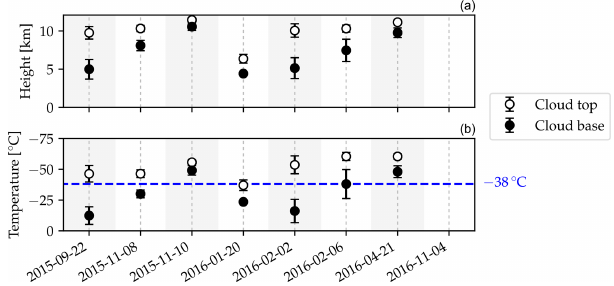
Figure 7. (a) Cloud top (circles) and base (dots) height were de- rived from cloud radar observations. (b) The corresponding tem- perature was estimated from radiosonde profiles launched at Ober- schleißheim. The dashed blue line indicates the threshold for ho- mogeneous nucleation at a temperature of − 38 ◦ C. The results are provided by the mean values within a 1 σ confidence interval over the time periods with a visible 22 ◦ halo.